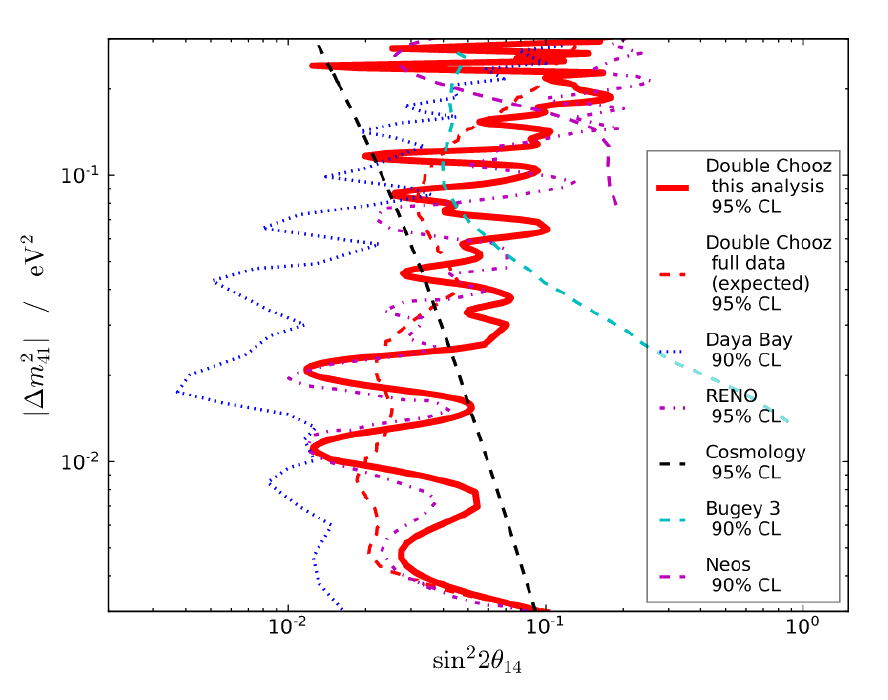
Figure 2. Exclusion contours of the kilometre-baseline reactor experiments in the plane of (cid:2) (cid:3) sin 2 ( 2 θ ee ) , ∆ m 2 alongside NEOS’ contour. Reprinted from [41] under CC BY 41